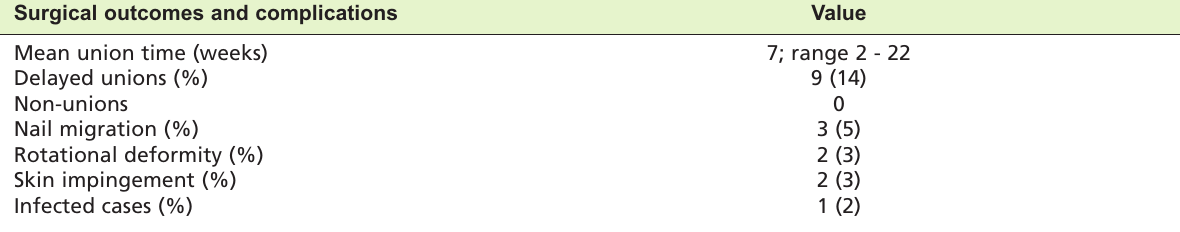
Surgical outcomes and complication Table III: